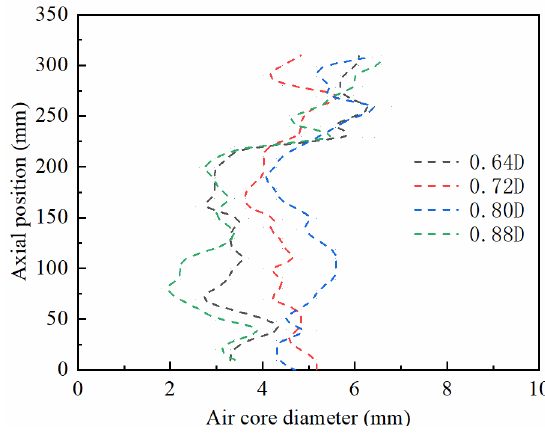
Figure 8. Boundary curve of air